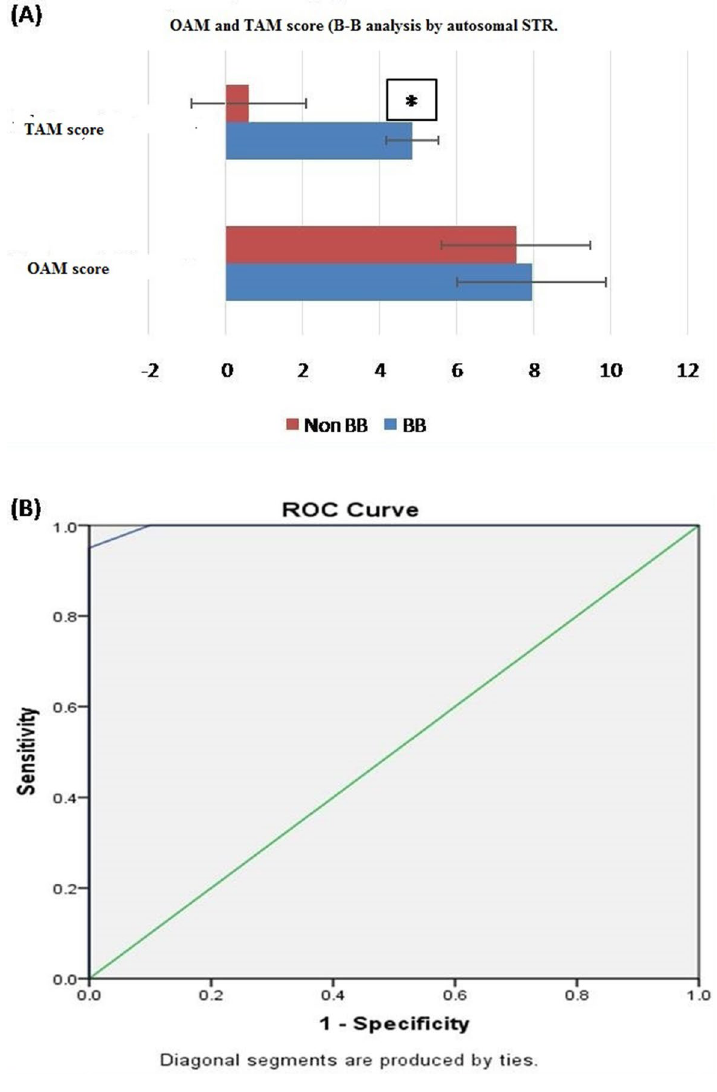
Figure 3. ( A ) TAM score for B-B analysis by autosomal STR. Based on the TAM score statistically significant difference between B-B (related) and non-B-B (unrelated) group was seen with autosomal STR. The average TAM score for B-B is 4.85 ± 1.496 (SD), whereas, for the non-B-B group, the average TAM is 0.60 ± 0.681 (SD). Figure 3 (A & B) obtained from SPSS software version 22.0 (Available for download at: https:// www. ibm. com/ suppo rt/ pages/ downl oading- ibm- spss- stati stics- 22). *Statistically significant difference (p < 0.05). ( B ) ROC curve (AUC 99.7%), showing the performance of TAM score as a screening test for B-B pairs by autosomal